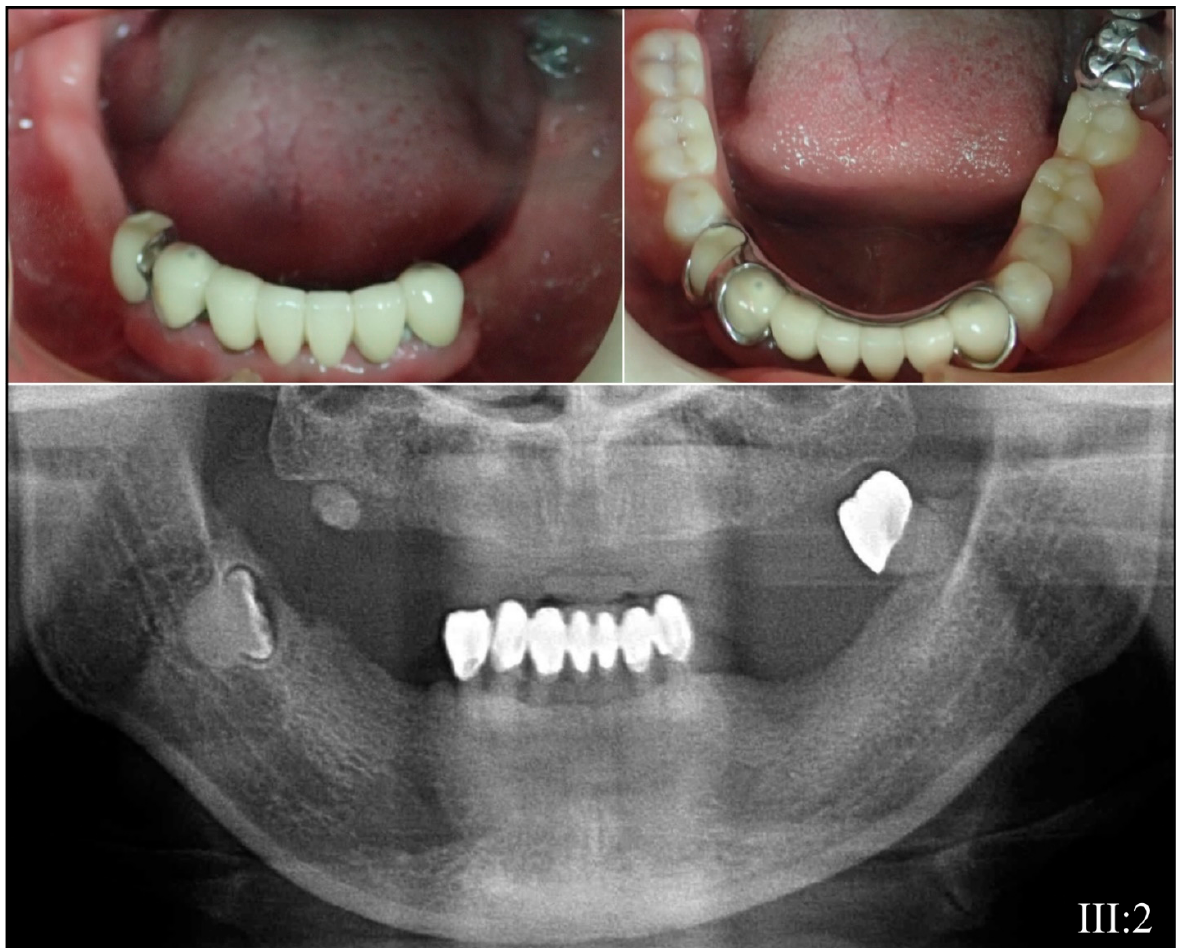
Figure 6. Family 3. Photographs and panorex from the affected mother (III:2) showing complete pulp obliteration of the few remaining, reconstructed teeth. obliteration of the few remaining, reconstructed